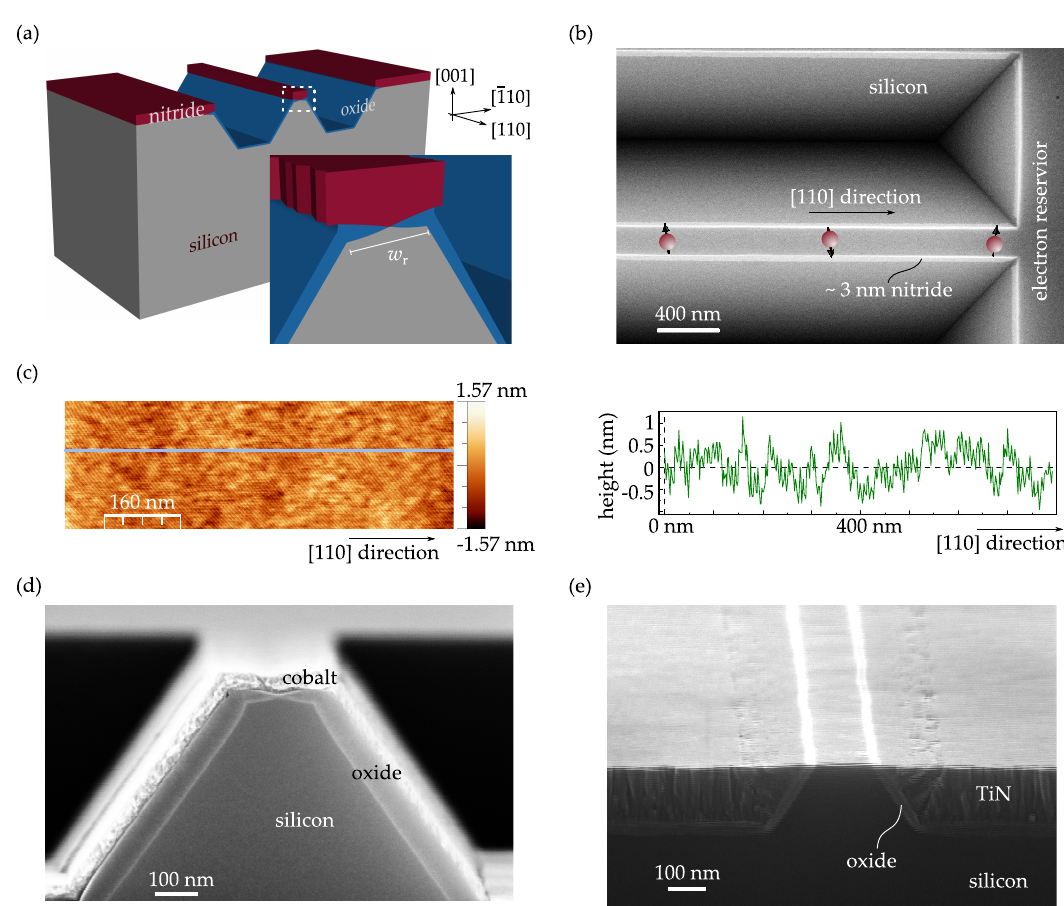
Figure 3. Fabrication, polishing, and topology of the silicon nano-ridge. ( a ) Schematic drawing (not to scale) of the silicon nano-ridge realized with anisotropic wet-etching of <100>-oriented silicon and dry oxidation. The inset depicts a close-up of the tip-area of the nano-ridge. ( b ) Top-view scanning electron micrograph (SEM) image of the trapezoidal structure formed after TMAH-etching. A small undercut of the thin silicon nitride hard mask is visible at the edge of the line structure, which reduces the impact of line-edge roughness of the initial lithography process on the resulting {111} facets. ( c ) Atomic force microscopy image of the etched (111) plane from a different sample with larger feature